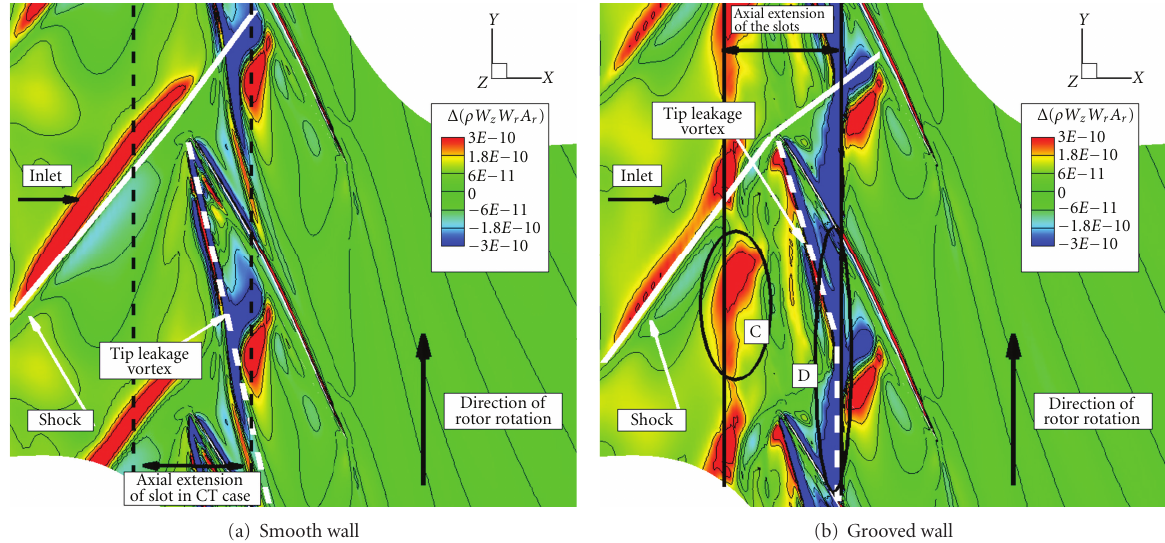
Figure 21: CBUAA: Flow field denoted at midgap by negative values of Δ ( ρW z W r A r